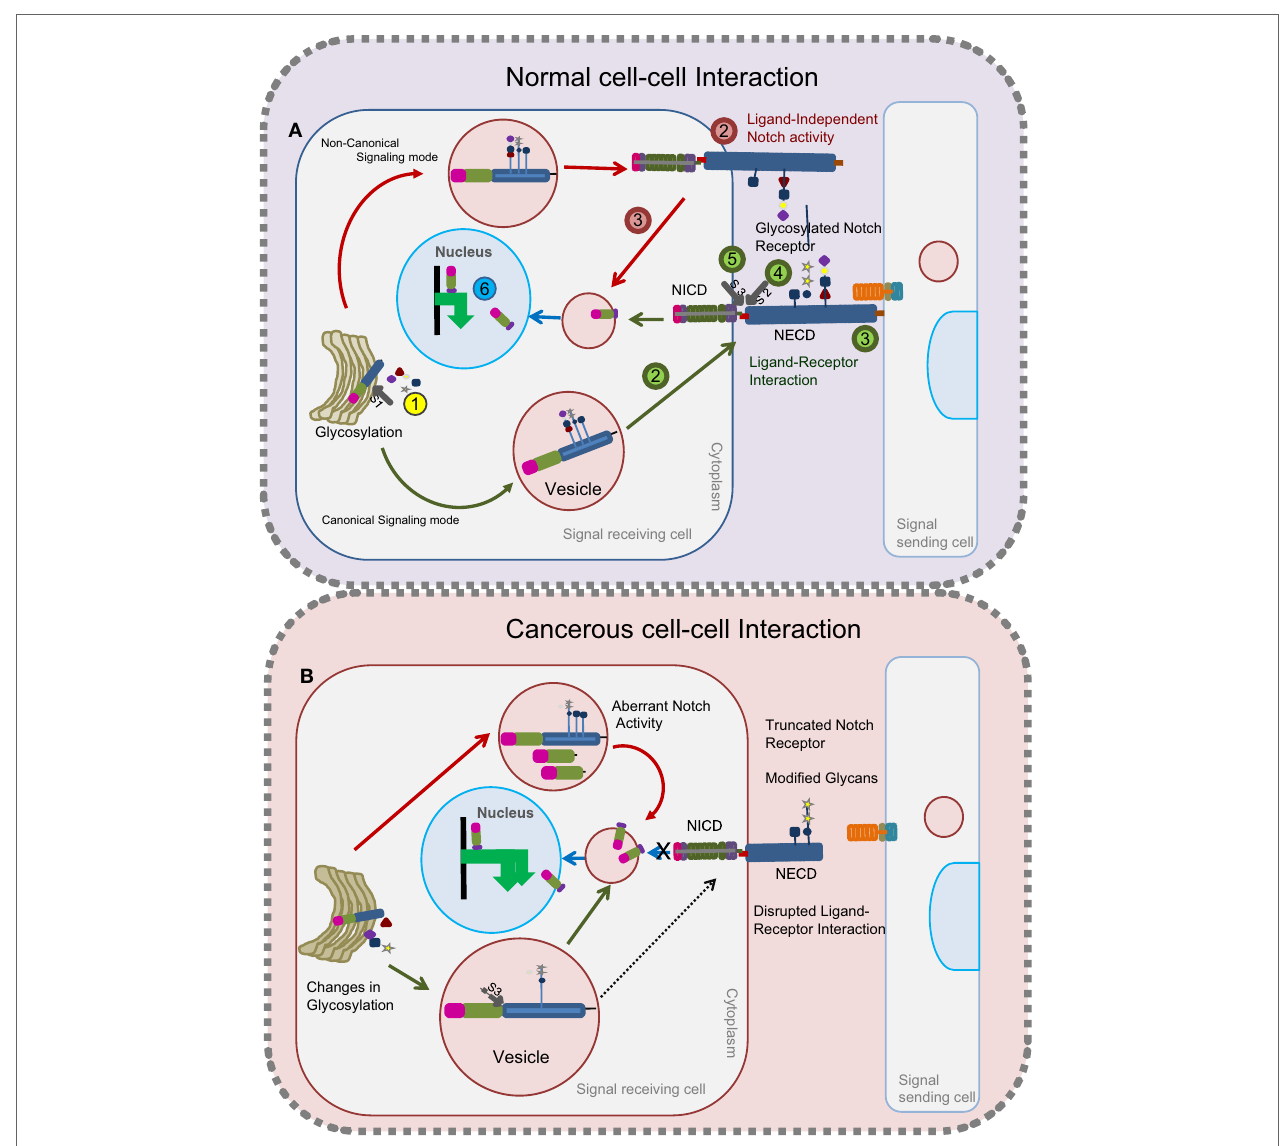
FiGURe 1 | Glycosylated notch-mediated cell–cell interactions in normal cells and cancerous cells . In normal cells (A) , glycosylation on the Notch receptor takes place in the Golgi bodies followed by proteolytic (S1) furin cleavage (Step 1, yellow). Depending on the glycosylation cues, glycosylated Notch receptor takes either a canonical route (as shown by green arrows) or a non-canonical route (as shown by red arrows) to release the NICD fragment. Through the canonical mode (green) of a signal-receiving cell, glycosylated Notch receptor is transferred to the plasma membrane (Step 2) to interact with the ligands on the signal-sending cell (Step 3). Following this, the Notch receptor undergoes two successive proteolytic cleavages (S2) (Step 4) and (S3) (Step 5) to release the NICD that translocates into the nucleus to activate target genes (Step 6). In the non-canonical route (red), the Notch receptor does not interact with ligands (Step 2) but gets proteolytically cleaved inside the vesicles to release the NICD fragment (Step 3) that translocates into the nucleus to activate the target genes (Step 6). In cancerous cells (B) , changes in glycosylation lead to the production of Notch receptors with modified glycans or truncated Notch receptors. Notch receptors with modified glycans undergo unusual S3 cleavage in the vesicles that releases NICD to activate Notch targets. Truncated Notch receptors and Notch receptors with modified glycans that reach the plasma membrane cannot interact with ligands on the signal-sending cell to release the